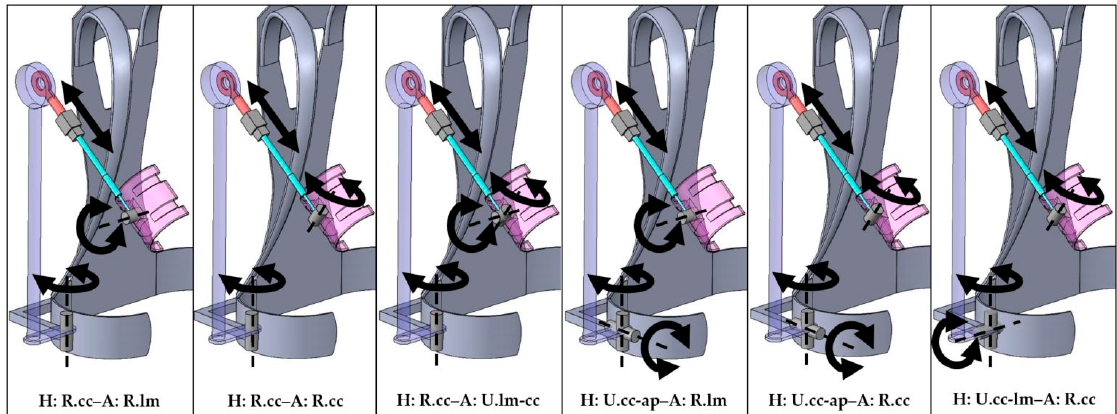
Figure 7. The six final exoskeleton variants are depicted with their respective joints (symbolized by grey blocks and cylinders). Corresponding DOF (axes of translation or rotation) are depicted with black arrows and dotted lines.